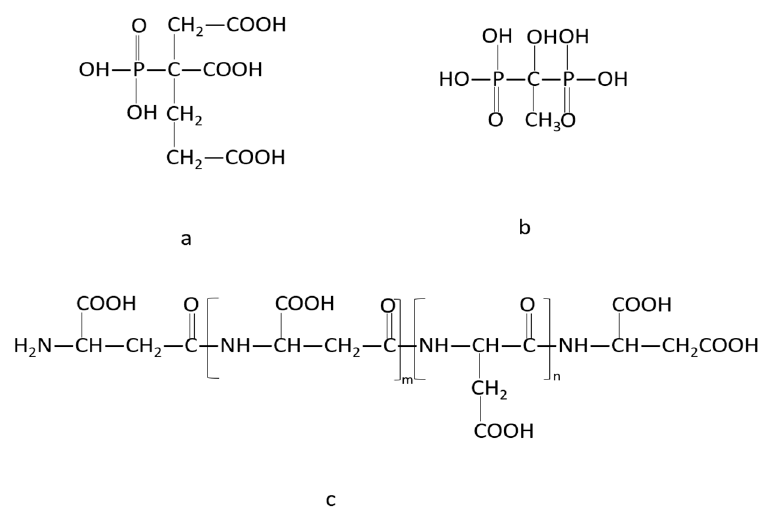
Figure 3. Molecular structures of 2-phosphonbutane-1,2,4-tricarboxylic acid (PBTCA) ( a ), hydroxyethylenediphosphonic acid (HEDP) ( b ) and polyaspartic acid (PASP) ( c ).